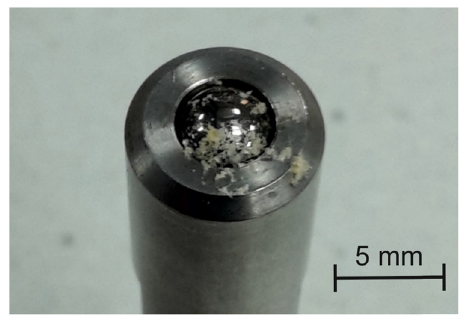
Figure 5: Photographs of surface of